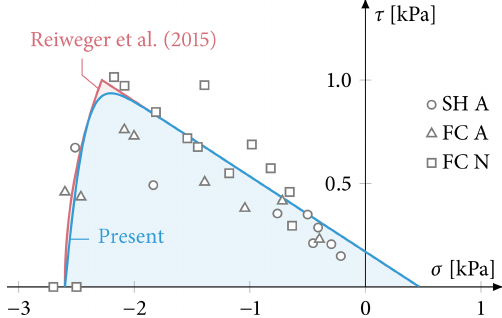
Figure 3. Smooth (present) and C 0 -continuous (Reiweger et al., 2015) capped Mohr–Coulomb weak-layer failure envelopes with experimental data on weak layers of natural surface hoar (SH N), natural faceted crystals (FC N) and artificial faceted crystals (FC A) as given by Reiweger et al. (2015), who performed laboratory exper- iments of weak-layer samples that were loaded in varying mixed- mode conditions. The properties chosen are as given in Fig.